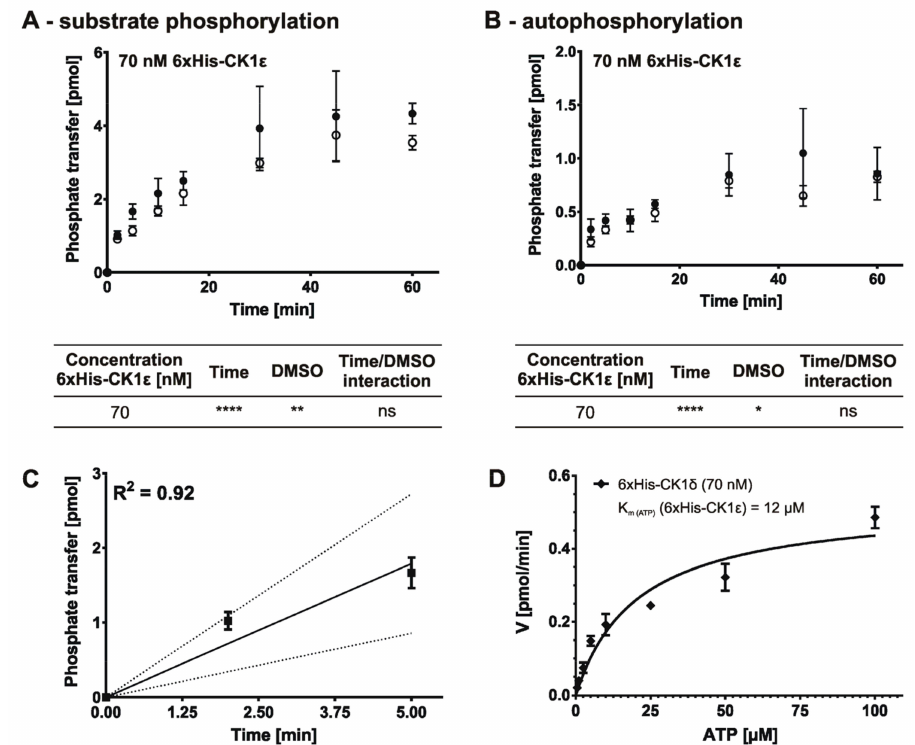
Figure 9. Product-over-time progression curve for 6 × His-tagged CK1 ε and Michaelis-Menten kinetics for 6 × His-CK1 ε assayed in presence of increasing ATP concentrations. ( A ) Time-dependent phosphate transfer from [ γ - 32 P]-ATP to the substrate α -casein catalyzed by human recombinant 6 × His-tagged CK1 ε using 70 nM enzyme concentration was determined by in vitro kinase reactions in absence and presence of solvent (+/ − DMSO). ( B ) Time-dependent autophosphorylation of 6 × His-CK1 ε has been determined and is presented similar to data shown in ( A ). ( C ) In order to determine the maximum coefficient of determination (R 2 ) linear regression analysis was conducted with stepwise decreasing the number of included time points of the product-over-time progression curve determined for 6 × His-CK1 ε (70 nM). Linear regression for the determined initial velocity region (5 min) including R 2 value and confidence bands (95 %) is presented in ( C ). ( D ) Initial velocity (V init ) [pmol/min] was determined at different ATP concentrations (0.5 to 100 µ M). K m (ATP) defines the concentration of the co-substrate ATP at which half of the maximal velocity (V max ) is achieved. Statistical significance was tested using two-way ANOVA (for data presented in ( A , B ). ns indicates p > 0.05, * indicates p ≤ 0.05, ** indicates p ≤ 0.01, **** indicates p ≤ 0.0001. DMSO, dimethyl sulfoxide; K m (ATP) , Michaelis constant for ATP; n, sample size; R 2 , coefficient of